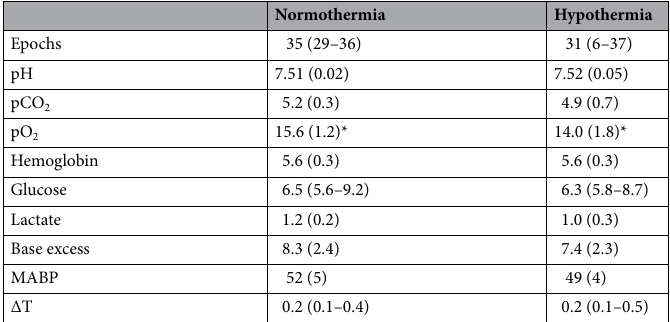
Table 1. Number of analyzed epochs from each animal, blood-gas measures, mean arterial blood pressure, and changes in temperature in six healthy, anaesthetised, newborn piglets exposed to 3 h of normothermia (38.5–39.5 °C) and 3 h of hypothermia (33.5–34.0 °C). Blood-gas measures and mean arterial blood pressure were measured every hour. Changes in temperature are during 15 min. Data presented as mean (± SD) or median (IQR). MABP mean arterial blood pressure, ∆T 15 min change in temperature. N = 5 for blood gas values, N = 6 for MAP and ∆T. * p < 0.05 compared with paired t-test or Wilcoxon